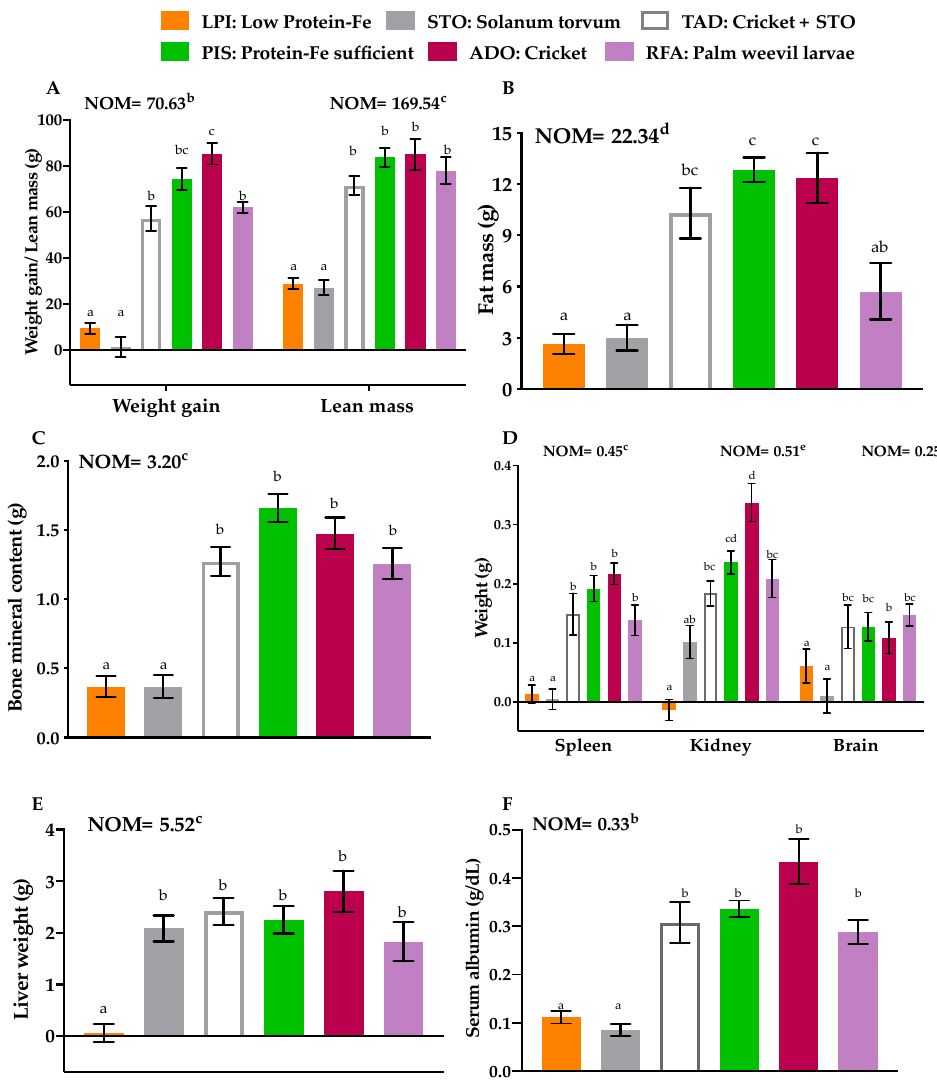
Figure 3. Effects of protein-Fe supplementation on body composition, organ weight, and serum albumin. ( A ) Weight gain, lean mass ( B ) Fat mass ( C ) Bone mineral content ( D ) Brain size, spleen, kidney weights ( E ) Liver weight, ( F ) Serum albumin. Data are presented as means ± SEM, n = 8, means with di ff erent letters di ff er ( p < 0.05) according to Tukey’s multiple comparison test. NOM: normal, fed protein-Fe su ffi cient diet throughout the study, LPI: Low Protein-Fe, STO: Solanum torvum , TAD: Cricket + STO, PIS: Protein-Fe su ffi cient, ADO: Cricket, RFA: Palm weevil